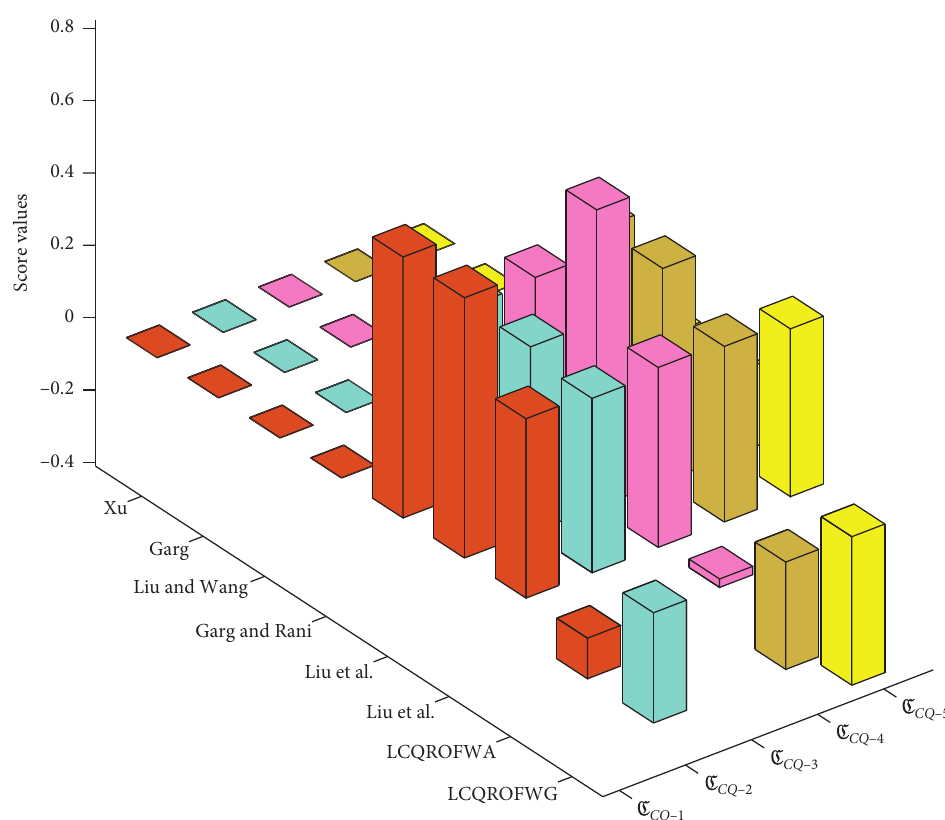
Figure 5: Graphical representations of the score values of the alternatives given in Table 8.